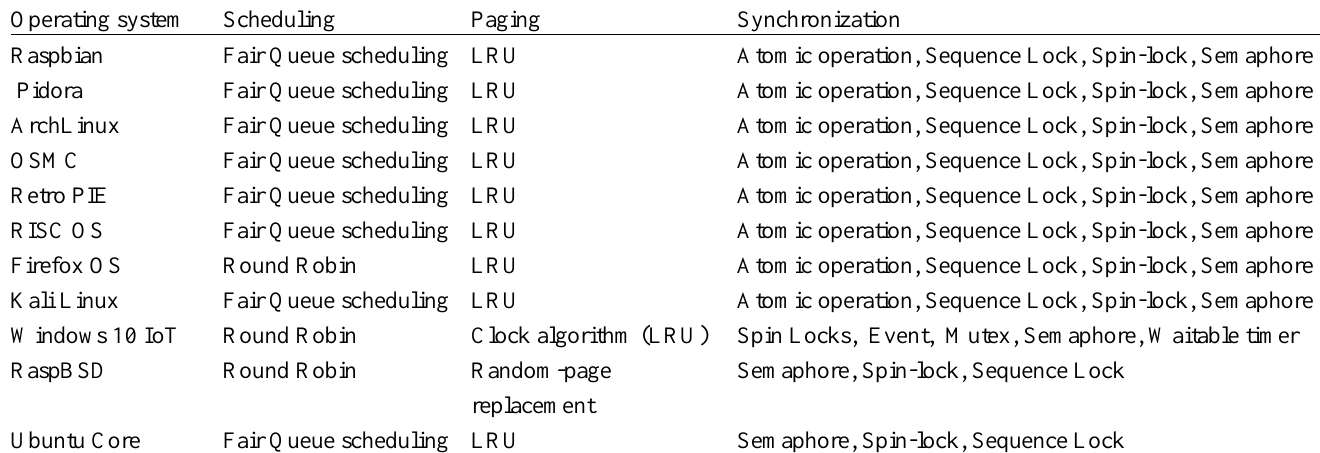
Comparisons of different Raspberry Pi operating systems in terms of scheduling, paging and